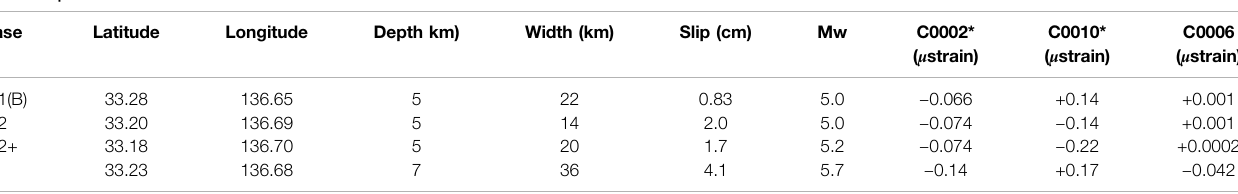
TABLE 5 | The best fi t fault model for Cases A-C. Case